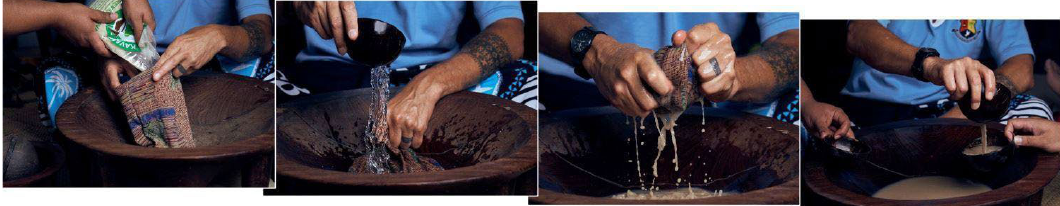
Kava and its attendant practices play a significant cultural role where it is used as medicine, to acknowledge hierarchies, bless and protect structures and ventures, and give efficacy to events (Aporosa, 2019a). Its ability to induce a relaxed, yet cogent, state in the drinker means it is commonly used to facilitate quality discussion and decision-making as part of talanoa , a Pacific dialogue process (Aporosa,